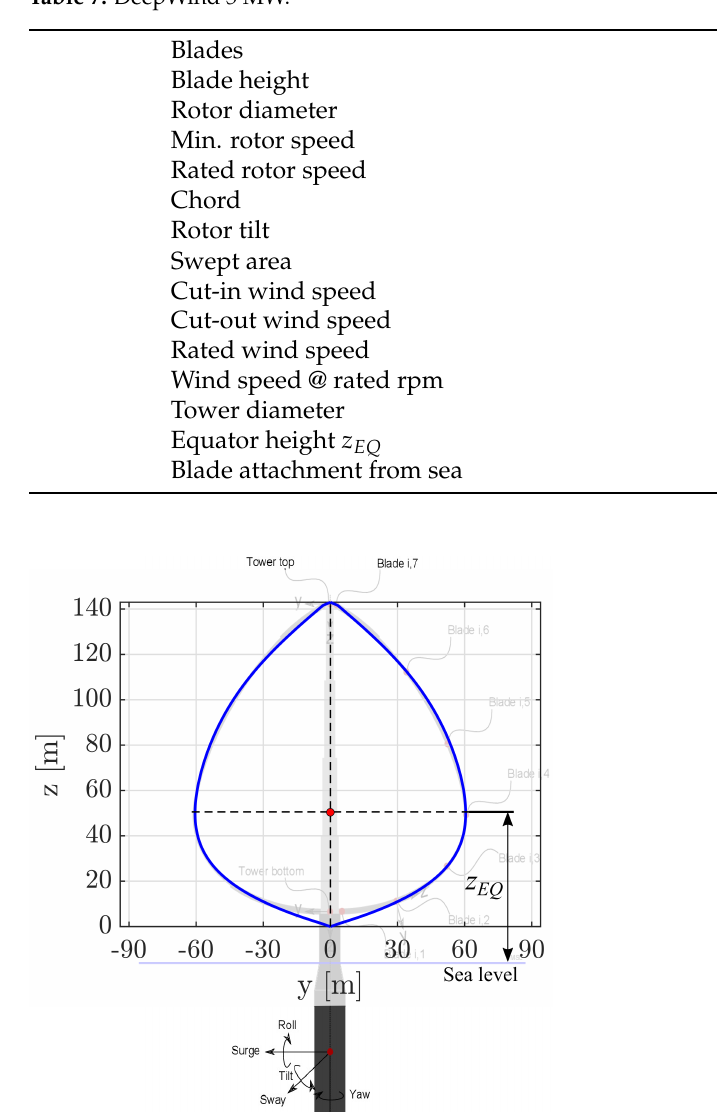
Table 7. DeepWind 5 MW.